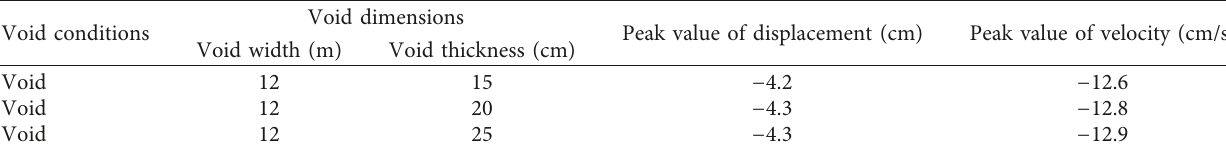
Figure 10: Peak value variation curve for vertical velocity of the inverted arch: (a) void thickness is 10cm; (b) void width is 4m. Table 5: Peak value of vertical displacement and velocity (in the case of void width of 12 m).